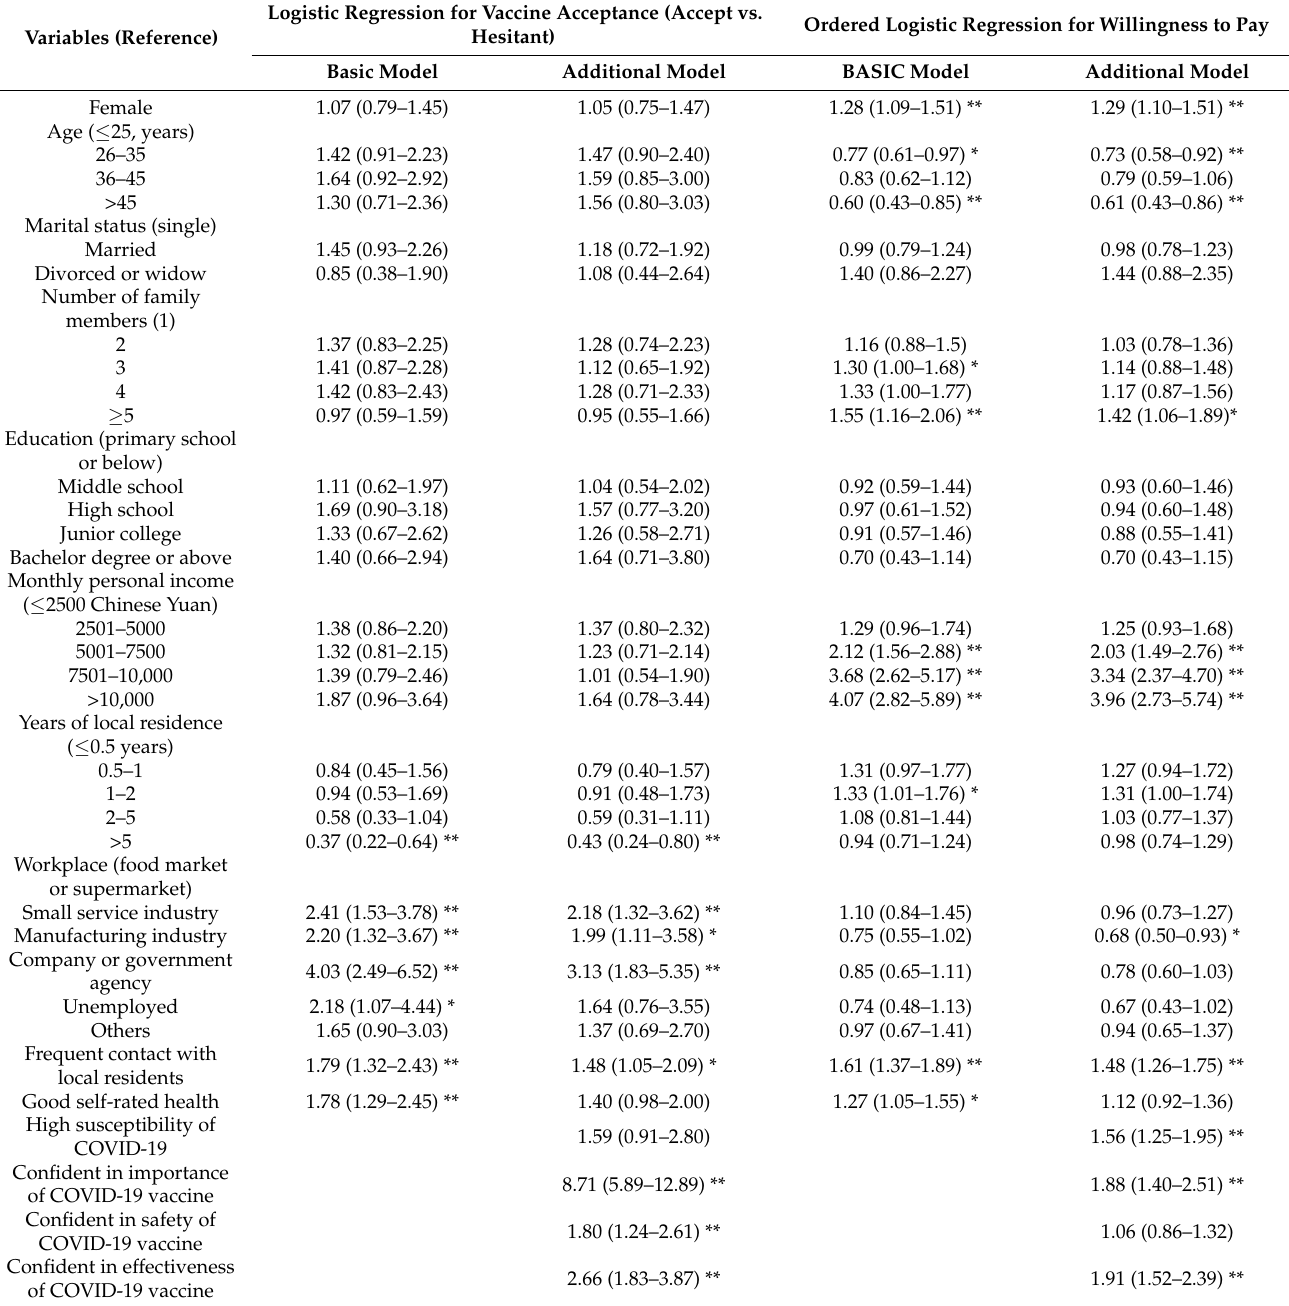
Table 2. Factors associated with acceptance and willingness to pay for COVID-19